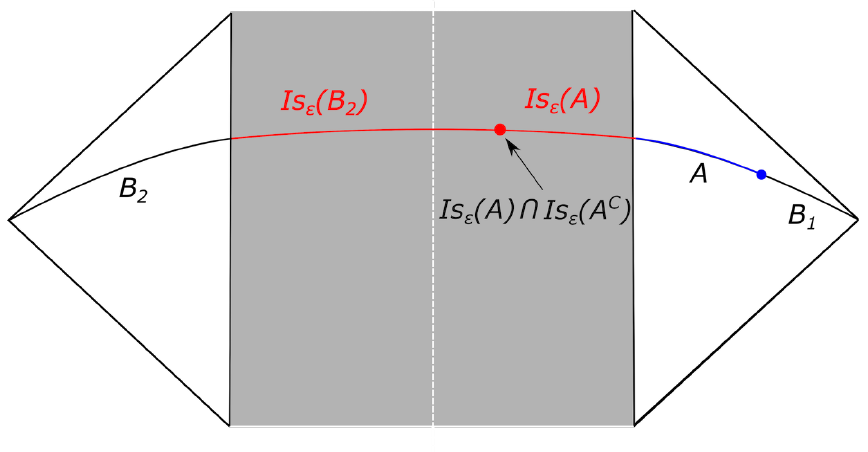
Figure 24: Schematic of a single interval in bath coupled to an eternal black